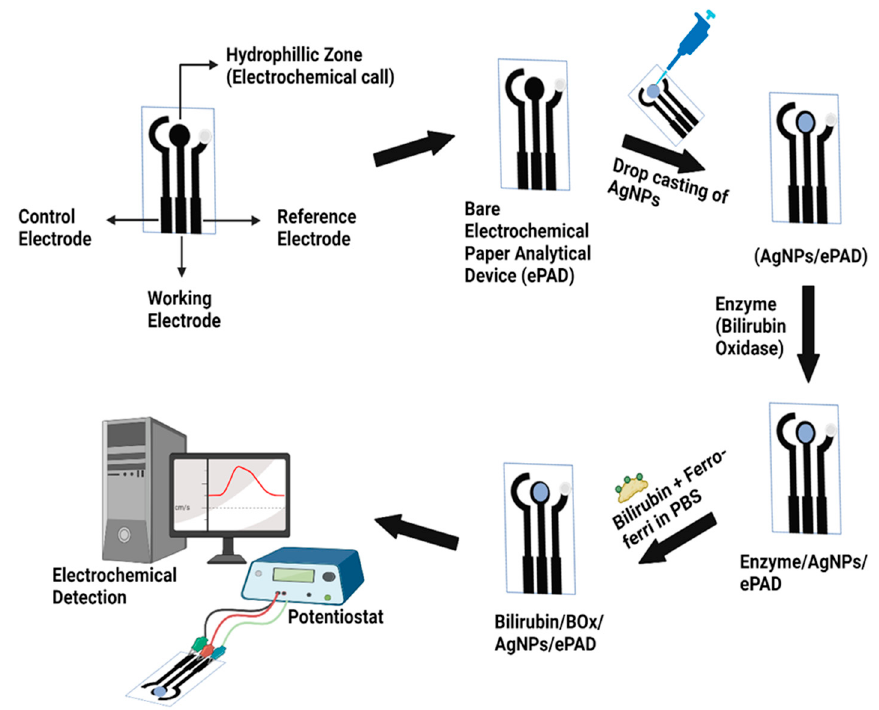
Figure 2. Schematic representation of working setup of